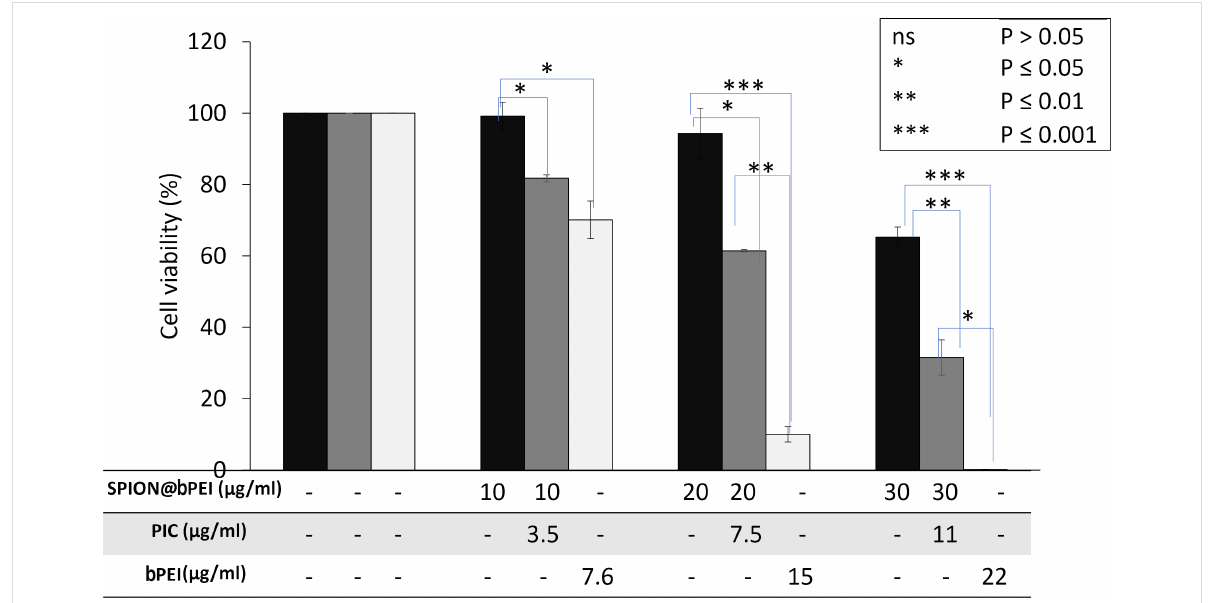
Figure 3: MTT cytotoxicity assay in HeLa cells treated with free bPEI, SPION@bPEI, and SPION@bPEI/PIC for 48 h (the doses are given in μ g). The amount of bPEI, PIC, and SPION@bPEI given under each column identifies the amount of each component in the formulation given to the cells. The results are expressed as the mean of three independent experiments ± standard error and subjected to one-way ANOVA with Tukey's test.